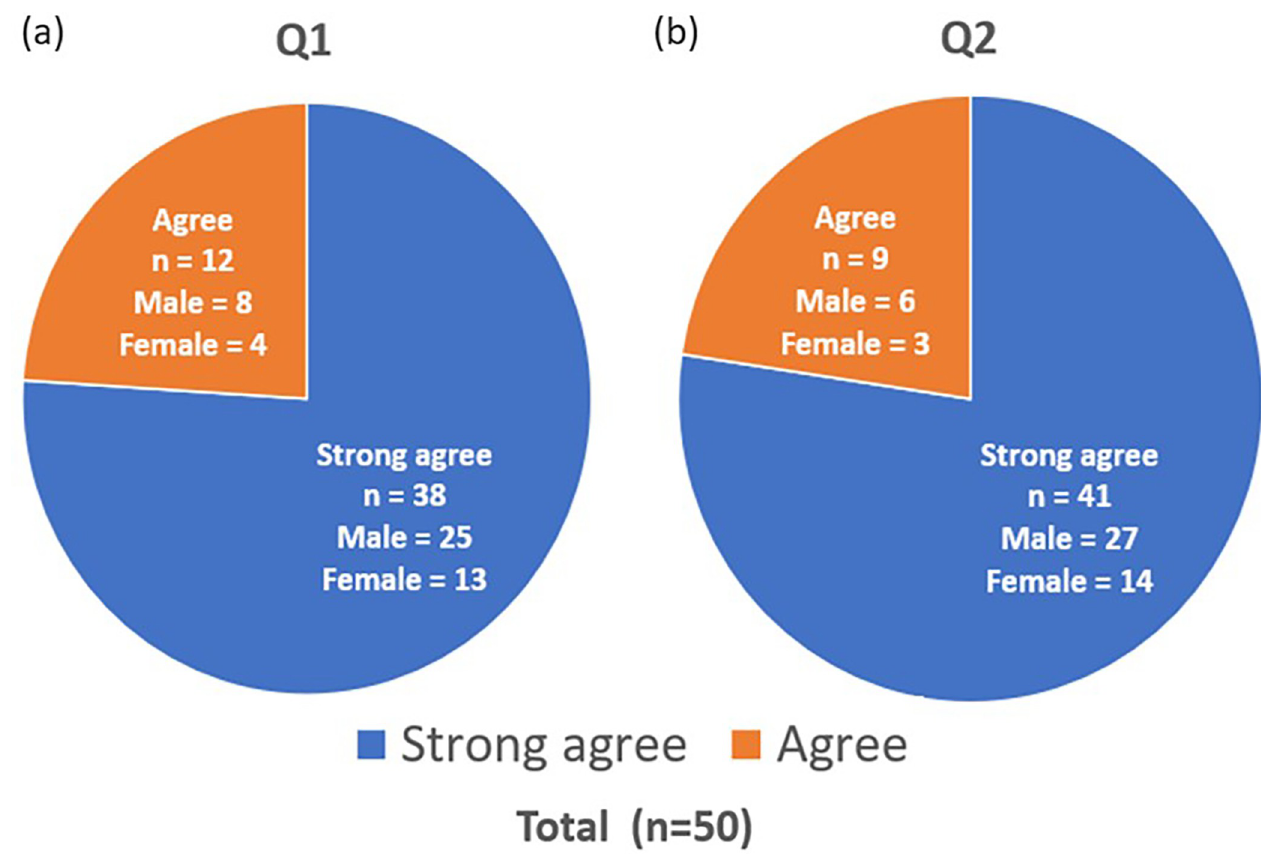
Fig 3. Patients’ response to educational pamphlet and video. (a) Q1. Compared to the educational pamphlet, does the educational video impress you more about the acne mechanism, treatment, and side effects of oral isotretinoin? (b) Q2. Compared to the educational pamphlet, does the educational video help you to understand the acne mechanism, treatment, and side effects of oral isotretinoin more